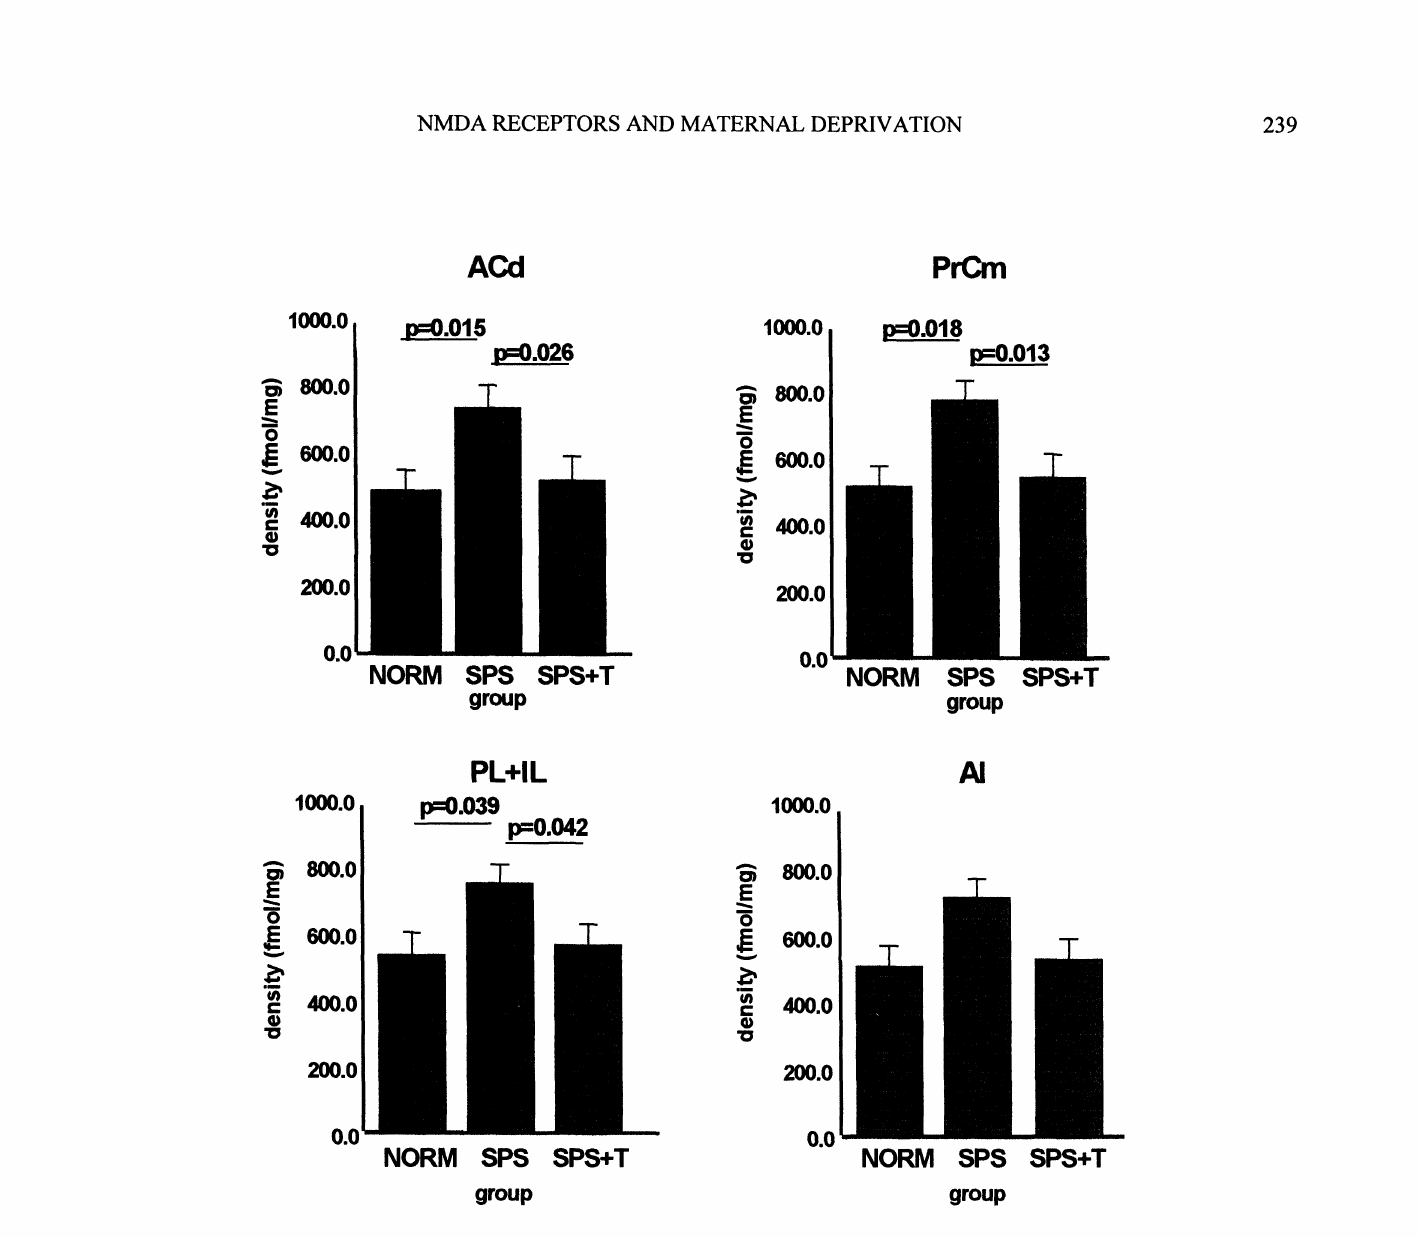
Fig. 3: Medial prefrontal cortex: Changes of NMDA-receptor density after brief parental deprivation and exposure to a novel environment (open field) with (SPS+T short parental separation + tone) and without (SPS short parental separation) presentation of parental vocalization. PrCM, precentral medial cortex; ACd, anterior cingulate cortex; PL+IL, pre- and infra-limbic cortex; AI, anterior insular